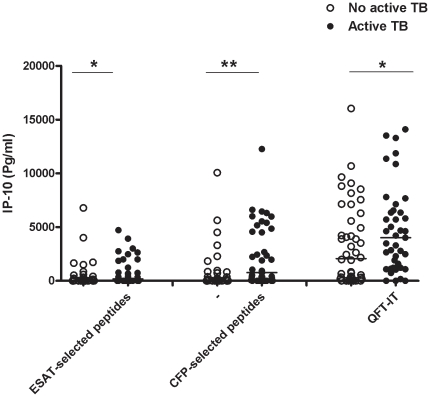
IP-10 production in response to RD1 selected peptides and QFT-antigen in HIV-infected individuals.IP-10 release in response to the RD1 selected peptides and QFT-antigen was evaluated at day 1 in the whole blood of patients with or without active TB. Horizontal lines indicate the median production. The data are presented as pg/mL. P values are reported, *: p<0.05; **:p<0.005. White circles indicate the individuals without active TB, black circles indicate the patients with active TB. IP-10 release in response to the RD1 selected peptides and to QFT-antigen was significantly higher in patients with active TB compared to those without.